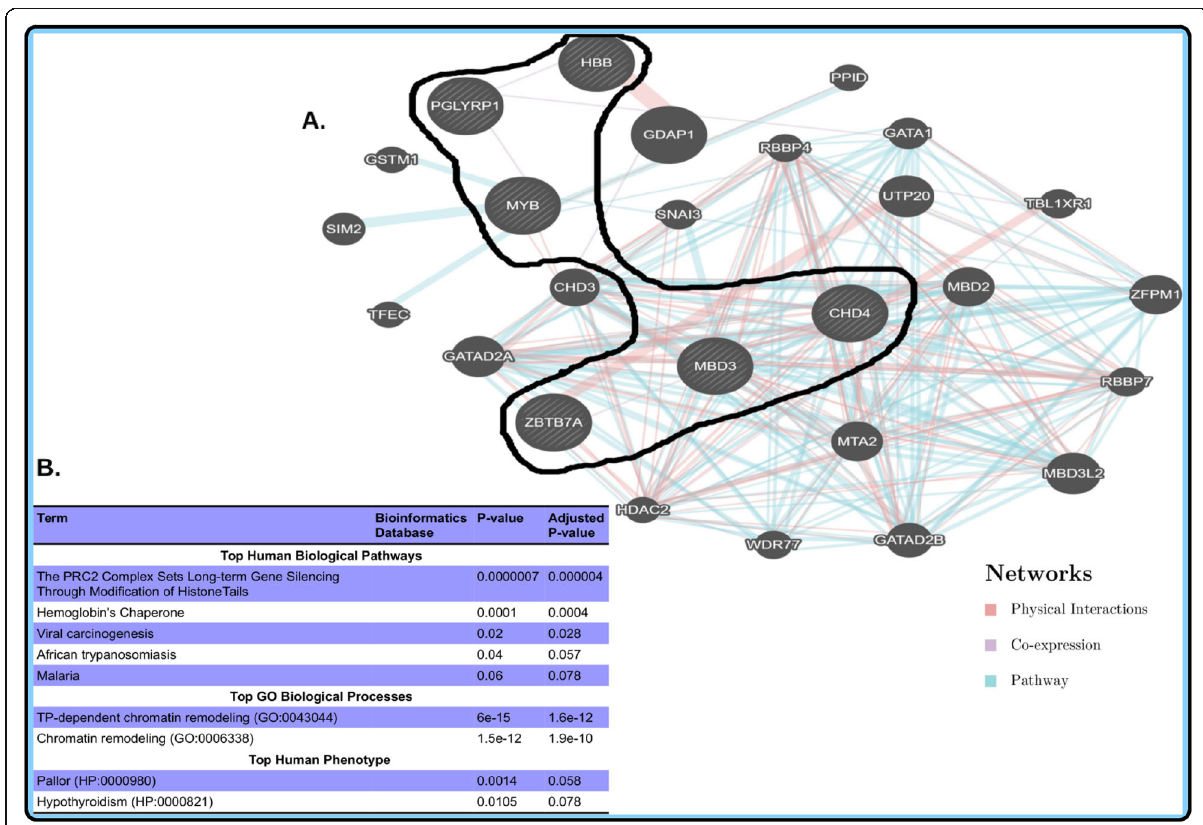
Fig. 3 Biological sub-network of the candidate mutant gene and identified modifier genes in 14 SCD patients from Tanzania. a sub-networks of the mutant gene and identified candidate genetic modifiers include CHD4 and MBD3 . b description of the top most significant pathways, GO biological process, and Human Phenotypes associated with the identified